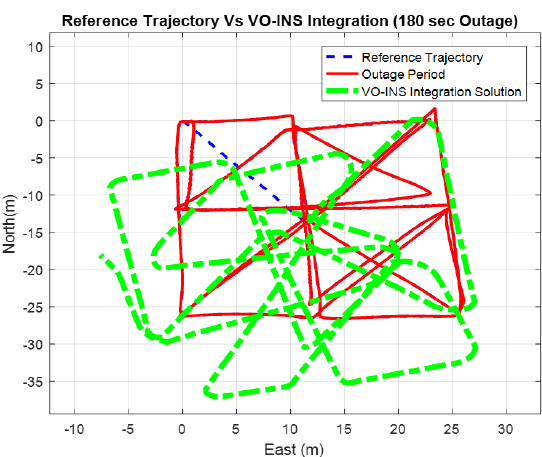
Figure 9. Performance of the integration between the camera and INS for 180 seconds of a complete signal outage